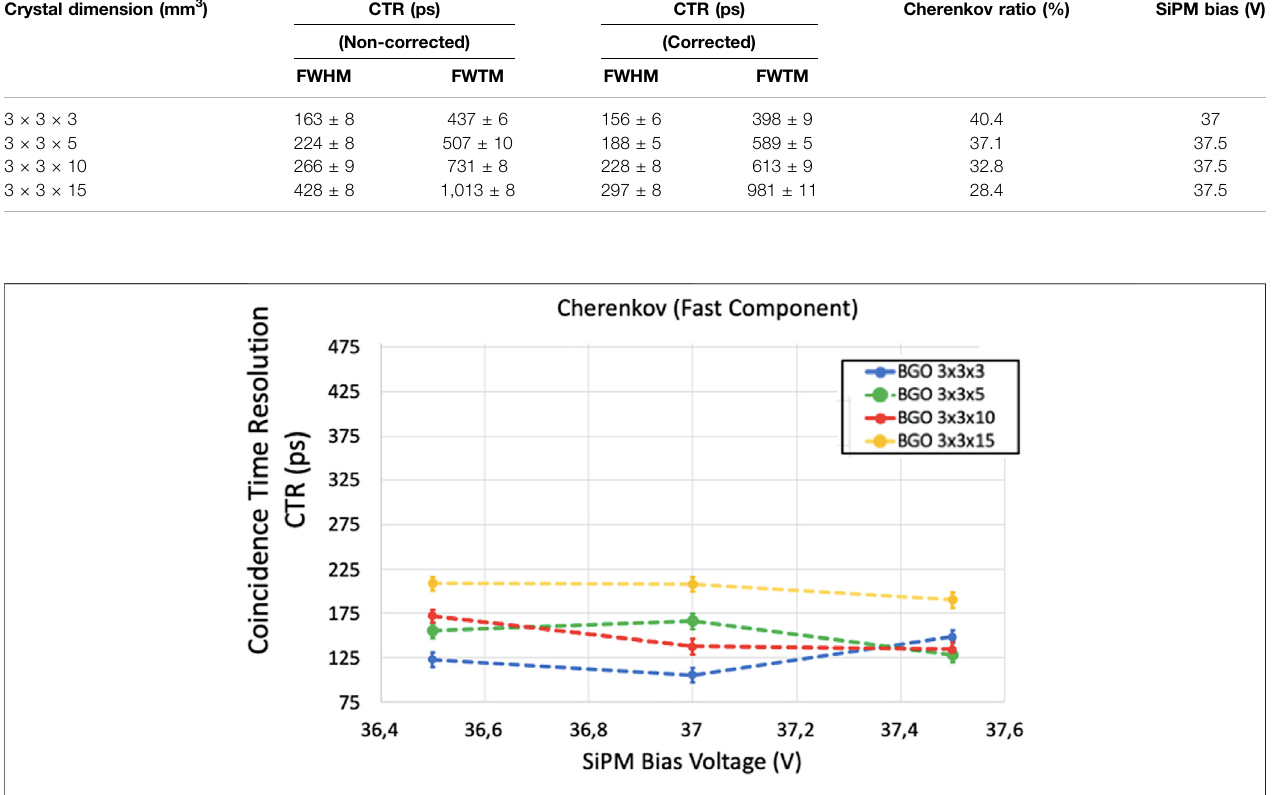
Frontiers in Physics |